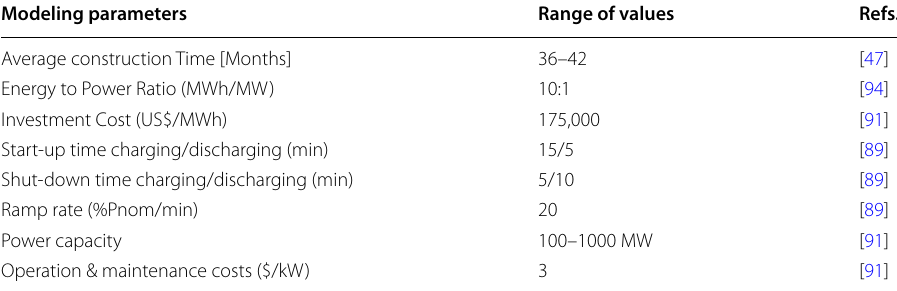
Table 2 Modeling characteristics of PHES Modeling parameters Range of values